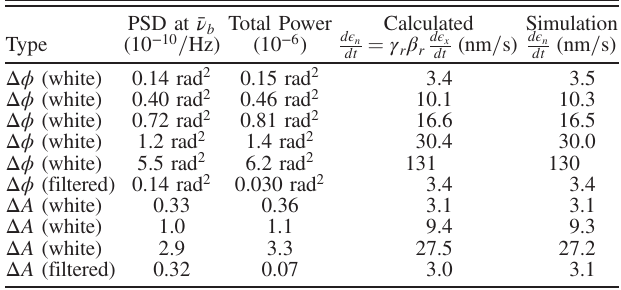
TABLE II. Simulation and estimated normalized